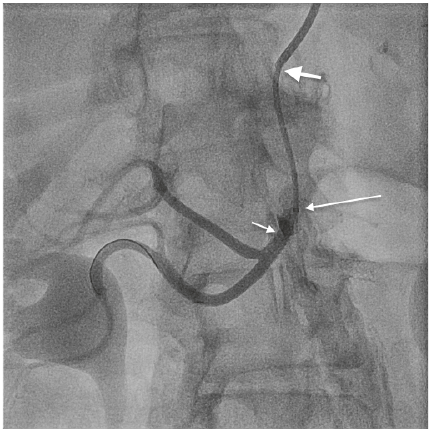
Figure 1: Renal artery ostial stenosis with distorted stent (short arrow). Long arrow represents tip of the GuideLiner and thick arrow represents tip of the Multipurpose guide catheter.